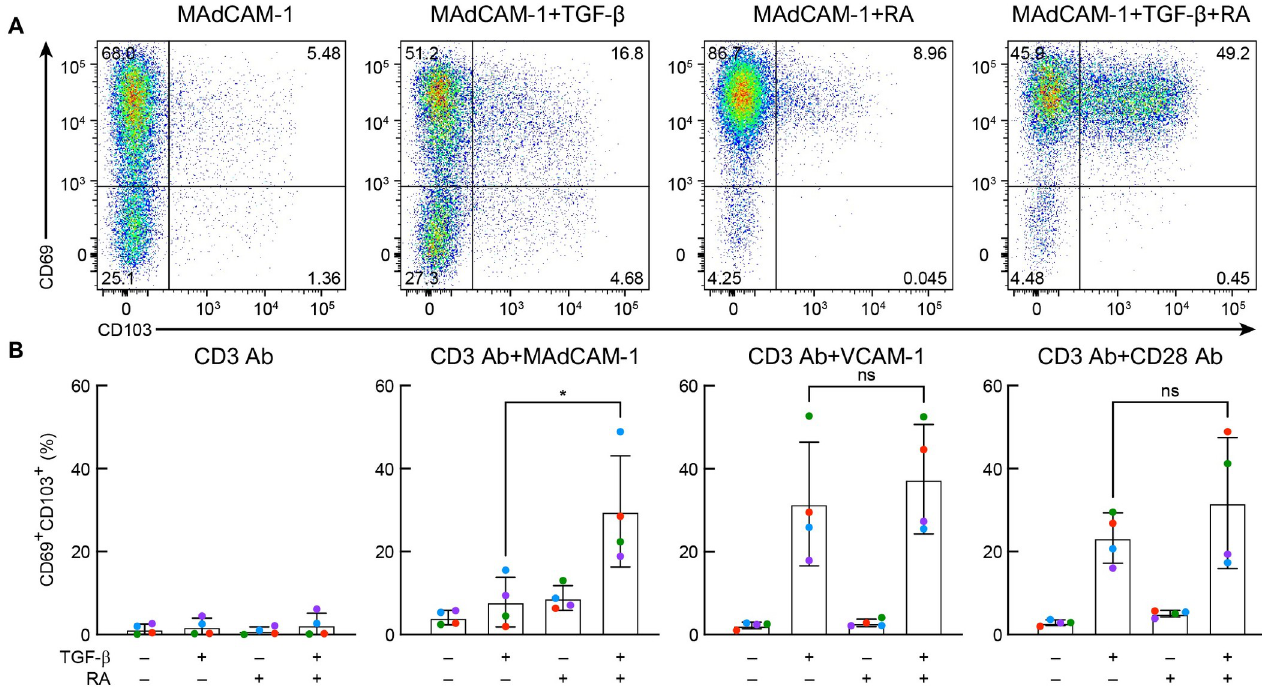
Fig 4. Effect of RA and TGF- β on CD69 + /CD103 + expression. ( A ) Representative flow cytometry dot plot of CD69 (Y-axis) and CD103 (X-axis) on CD3 Ab + MAdCAM-1 stimulated CD4 + T cells in the absence or presence of RA and TGF- β , as indicated. Percent of total cells in each quadrant, as indicated. ( B ) Average percent CD69 + /CD103 + cells following CD3 Ab alone, CD3 Ab + MAdCAM-1, CD3 Ab + VCAM-1 or CD3 Ab + CD28 Ab stimulation in the absence or presence of RA and TGF- β as indicated (n = 4). ( � : P < 0.05, two-tailed t test).